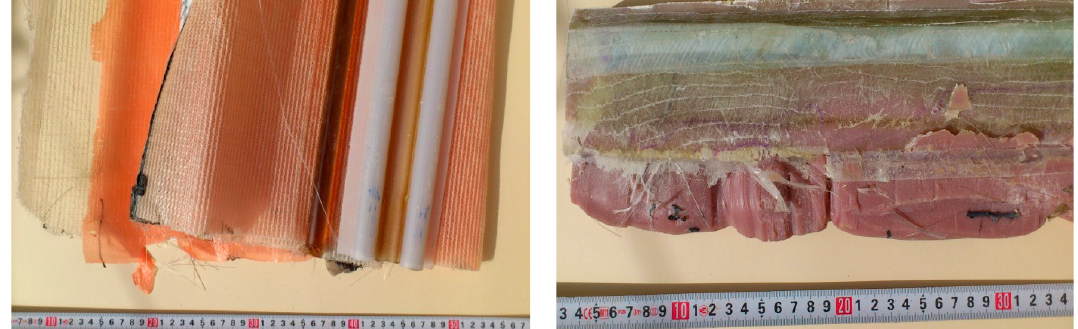
Figure 3. Investigated postproduction waste of wind power plant blades.